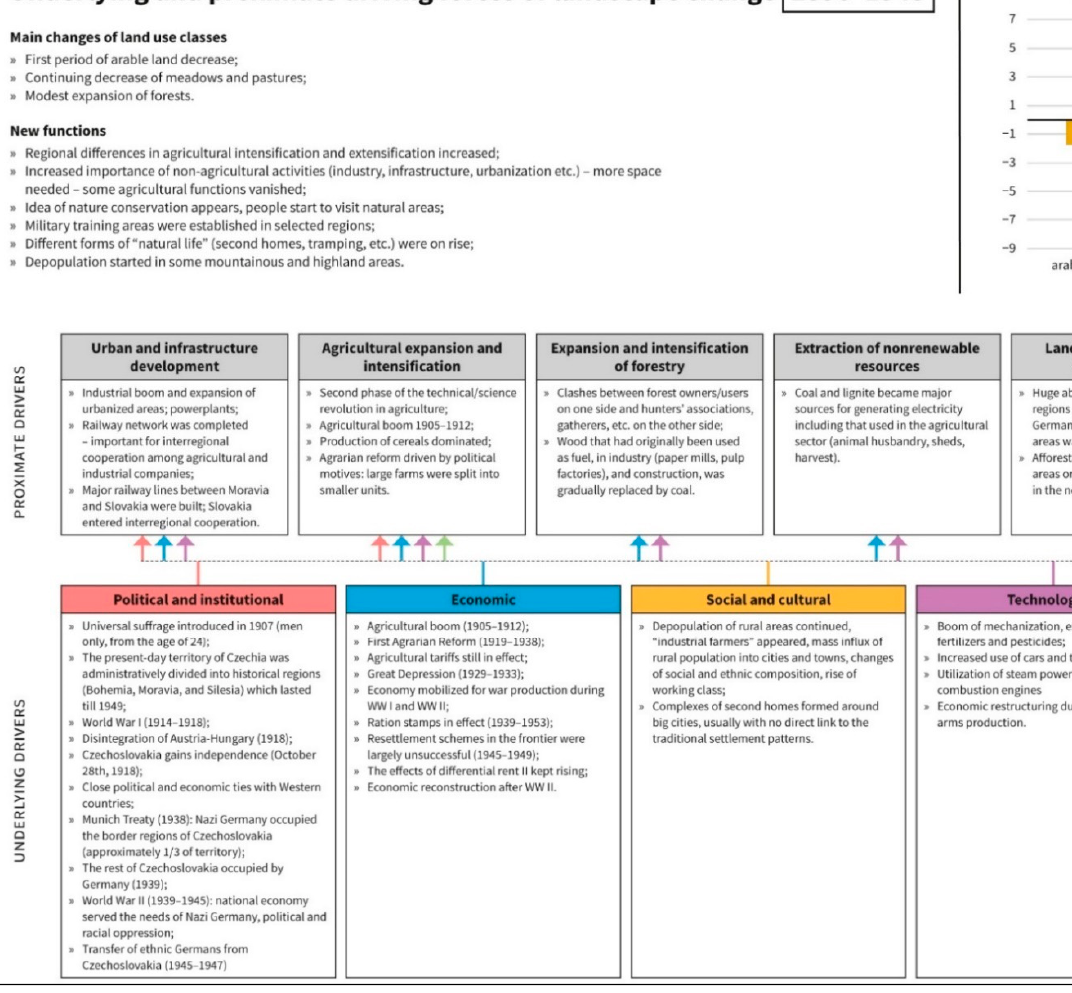
Figure A2. Underlying and Proximate Driving Forces of Landscape Change 1896–1948